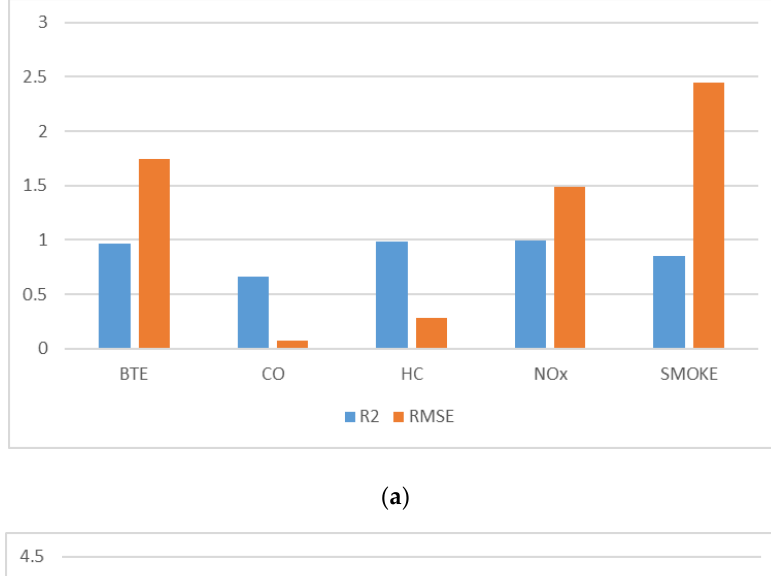
Figure 4. Depiction for comparing NMSE, NRMSE and MSRE of the model taking ( a ) 3 neurons; ( b ) 5 neurons; and ( c ) 7 neurons.